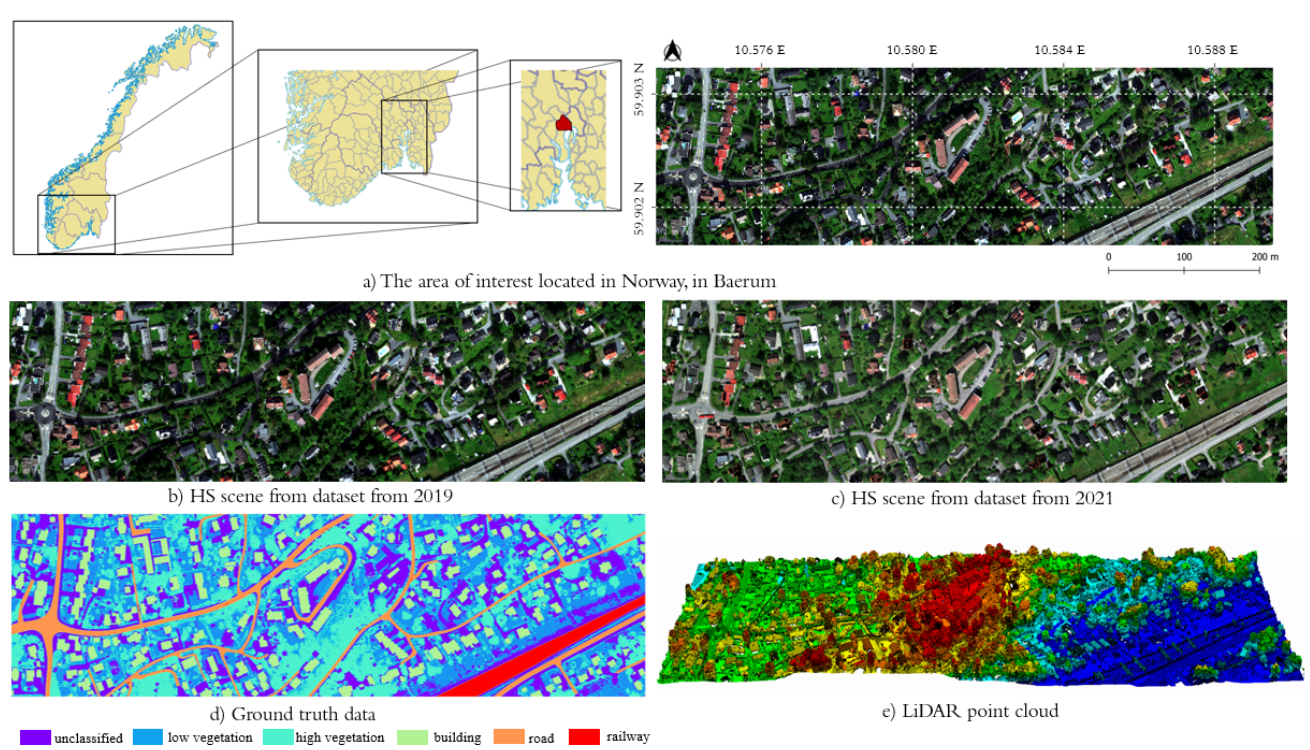
Figure 1. Our study area representing ( a ) the location of the area of interest, ( b ) the HS scene from 2019, ( c ) the HS scene from 2021, ( d ) the ground truth data, and ( e ) the LiDAR point cloud.